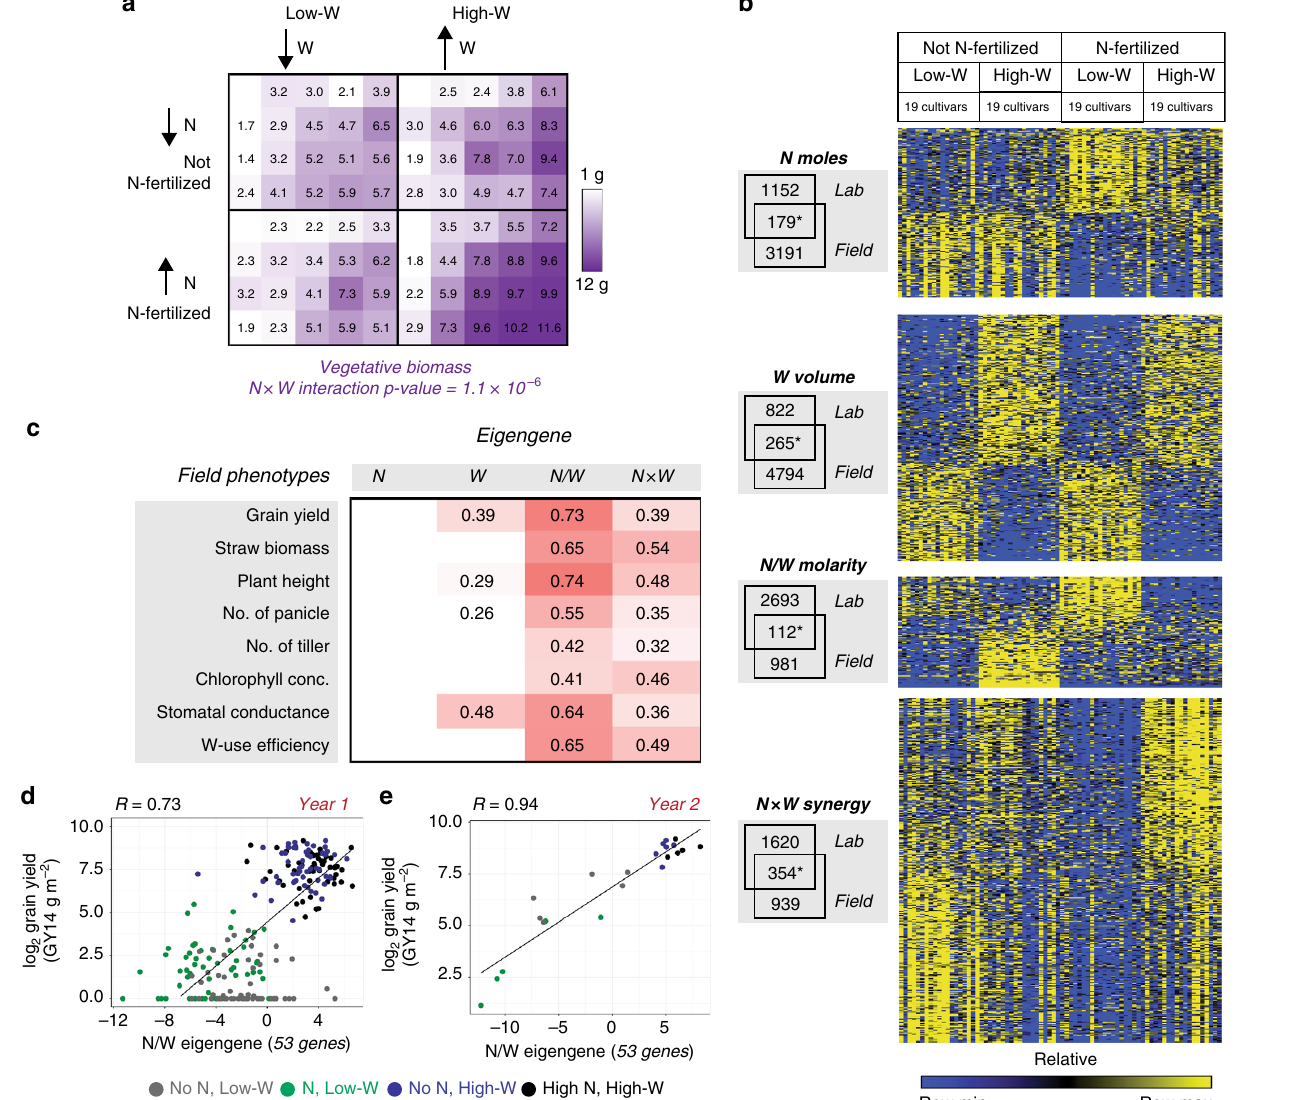
Fig. 4 Genes responding nonlinearly to combinations of N-fertilizer and W treatment are associated with agricultural outcomes. a Nineteen rice cultivars were grown in the fi eld under a 2-by-2 matrix varying N-fertilizer and W treatment; each cell indicates the average biomass of each of the 19 cultivars. The synergistic interaction N × W could best explain differences in shoot biomass (three-way analysis of variance interaction term, p = 1.1× 10 − 6 , F = 24.6, df = 1). b The genes responding to combinations of N- and/or W-dose in rice seedlings found under laboratory conditions overlap signi fi cantly with reciprocal classes found in fi eld-grown plants (*Monte Carlo, p <0.05). Normalized expression patterns of lab fi eld-validated genes are displayed in heatmap. c Eigengenes derived from each gene set were correlated with crop traits. Signi fi cant Pearson R values are shown in red (permutation test, p <0.05). d Example from c . Changes in N / W eigengene expression across 228 fi eld samples is associated with grain yield (gray: − N, − W, green: + N, − W, blue: − N, + W, black: + N, + W conditions). e N / W eigengene expression is predictive within an independent fi eld test set. Source data for b – e are provided in Source Data fi fi eld experiment the following year (Supplementary Fig. 7), and sequenced the transcriptomes of two genotypes that varied in their yield outcomes. Through repeating our eigengene analysis on this independent fi eld data test set, we validated that genes whose expression patterns is best explained by changes in N and W combinations — N / W or N × W — were signi fi cantly associated with grain yield (Fig. 4d, e, Supplementary Fig. 8).